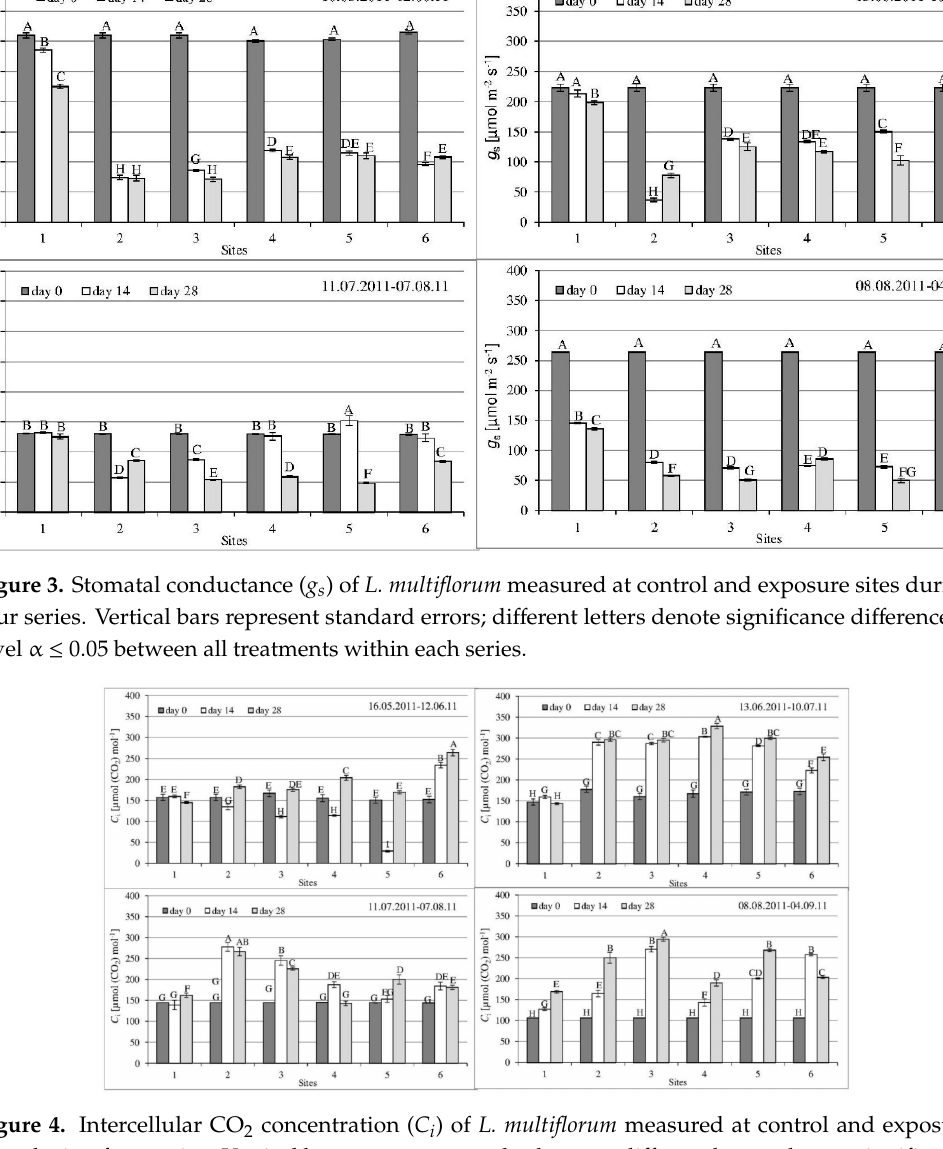
Figure 4. Intercellular CO 2 concentration ( C i ) of L. multiflorum measured at control and exposure sites during four series. Vertical bars represent standard errors; different letters denote significance difference at level α ≤ 0.05 between all treatments within each series.